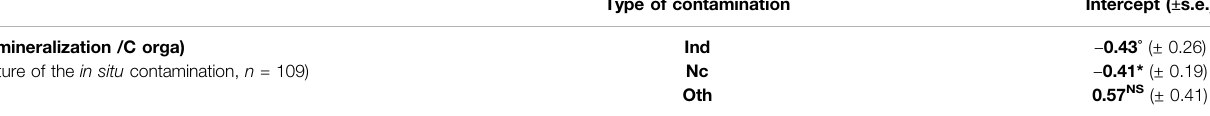
p -values symbols are explained in the legend of Table 2